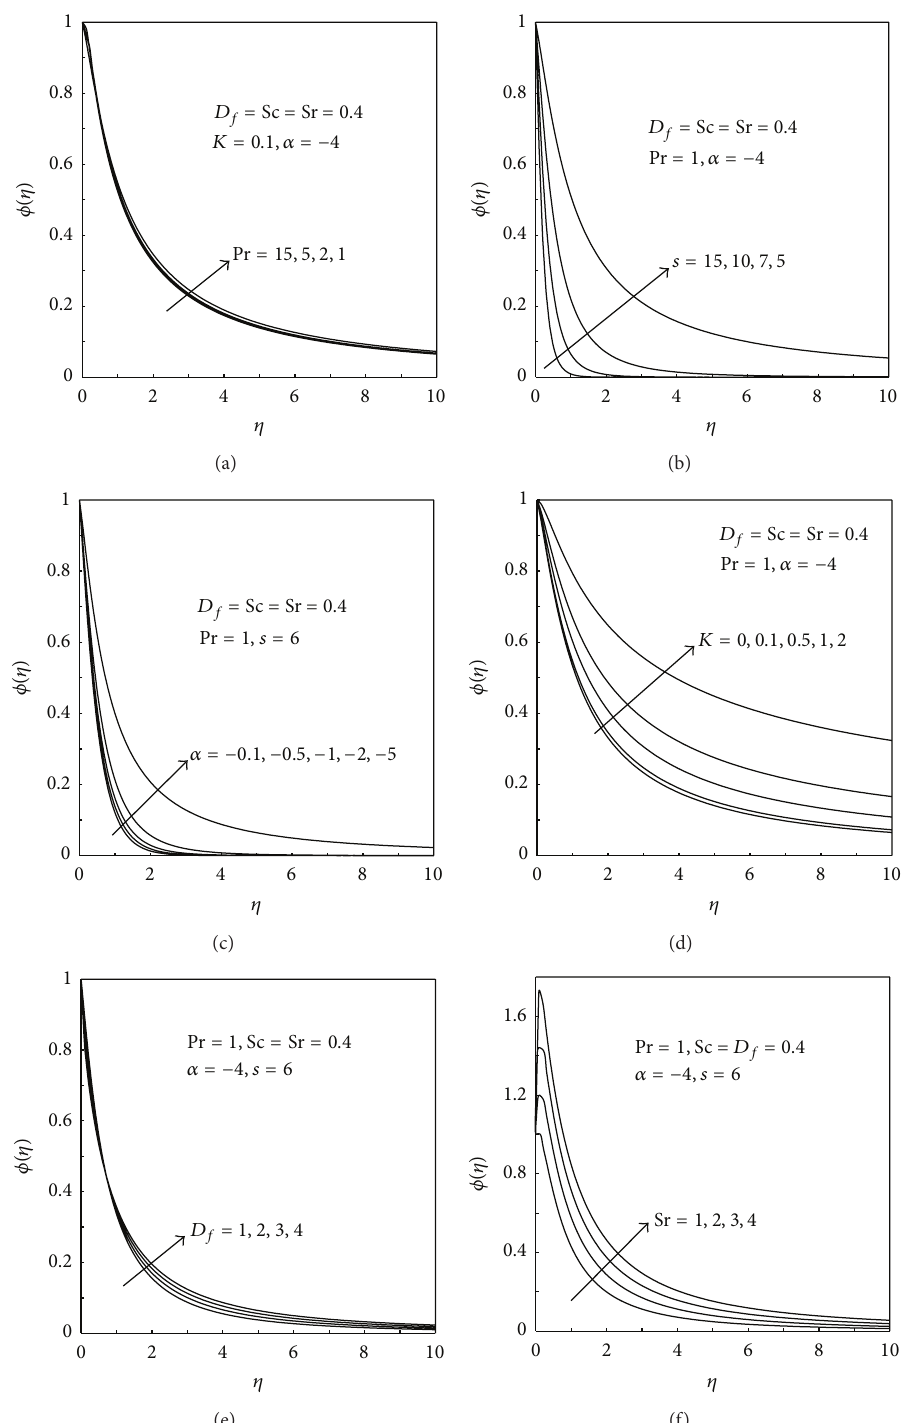
Figure 3: (a) Concentration profiles for a shrinking sheet under different values of Prandtl number. (b) Effects of the mass transfer parameter (mass suction) on the concentration profiles of a shrinking sheet. (c) Concentration profiles for different values of shrinking sheet strength with mass suction. (d) Effects of the permeability parameter on the concentration profiles of a shrinking sheet with mass suction. (e) Effects of Dufour number 𝐷 𝑓 on the concentration profiles of a shrinking sheet with mass suction. (f) Effects of Soret number Sr on the concentration profiles of a shrinking sheet with mass